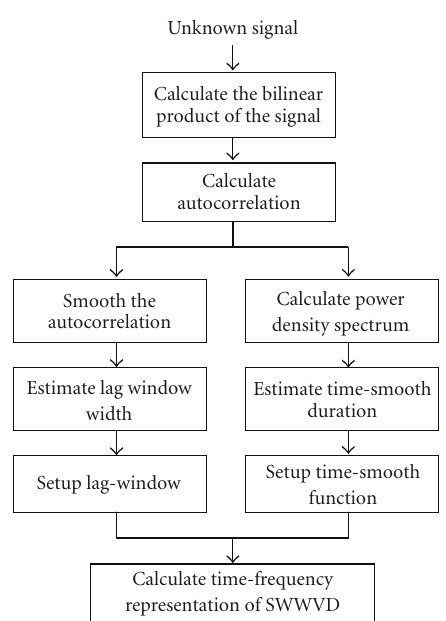
Figure 7: System design of adaptive